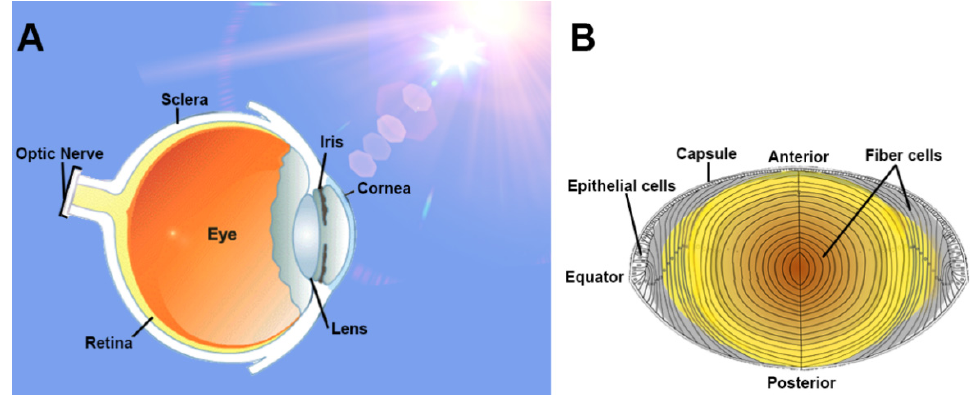
Figure 3. The lens: function and structure. ( A ) Light enters the eye through the transparent cornea and lens, which refracts light to focus onto the retina. Light information is converted into electrical impulses, which are sent to the primary visual cortex of the brain via the optic nerve. The lens is positioned in the anterior region of the eye and is therefore vulnerable to damage from reactive oxygen species (ROS) generated by UV radiation. ( B ) Schematic diagram of the human lens revealing the epithelial monolayer from where epithelial cells proliferate and differentiate at the equatorial zone to form differentiating fibre cells in the outer cortex. Fibre cells progressively lose their organelles, such as mitochondria and nuclei, as they become internalised, creating an inherent age gradient that encapsulates all stages of fibre cell differentiation throughout the lifetime of an individual.